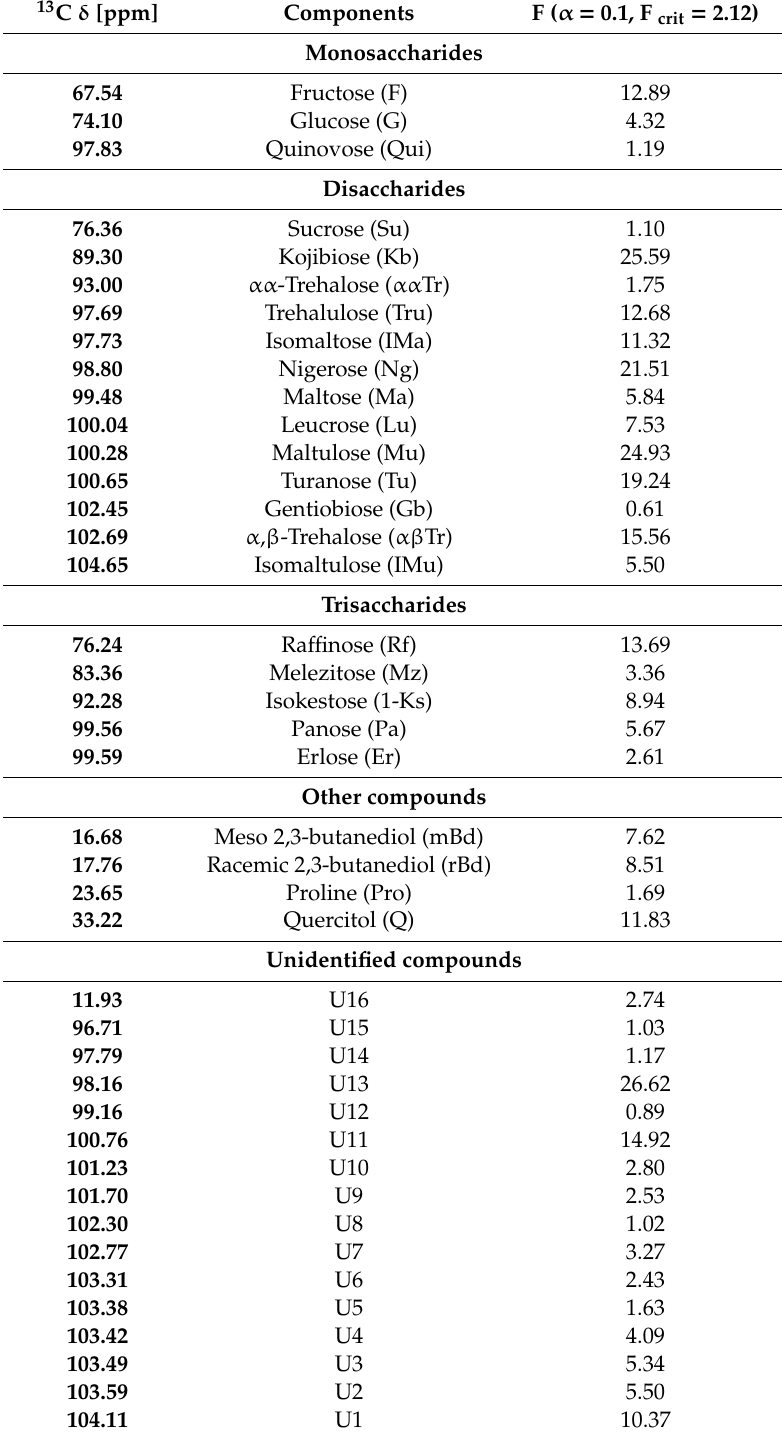
Table 1. Chemical shifts of used signals and their F*